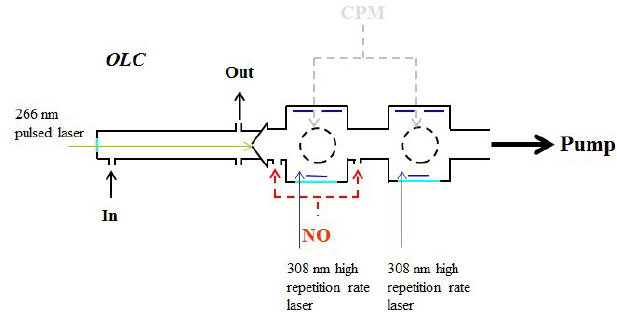
Figure 2. Experimental investigation of the deviation from pseudo first-order kinetics for the MD-CRM measurements. Laboratory (2 October) and field (7 October) additions of standard gases are shown on this figure. Ambient measurements must be multiplied by 0.91 when the CRM instrument is run at an effective pyrrole-to-OH ratio of 1.7.